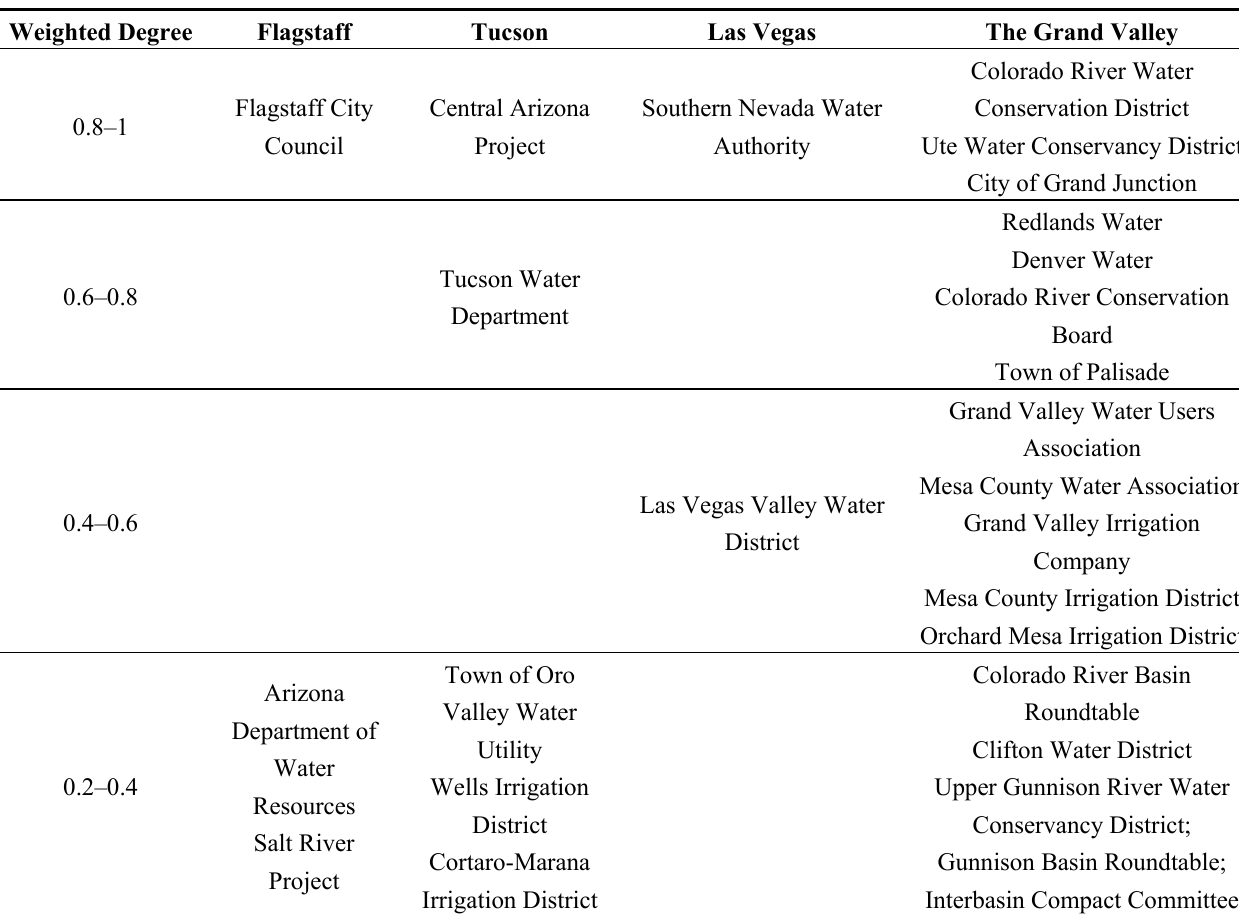
Table 10. Selected values from the graph in Figure 7, grouped by